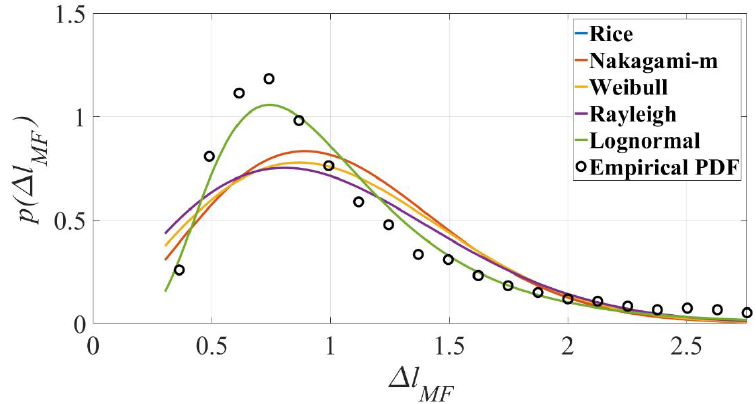
Figure 5. Exemplary results of the selected PDFs fitted to the empirical distribution of multipath fading (for DEP, AB L , NB, and LOS).